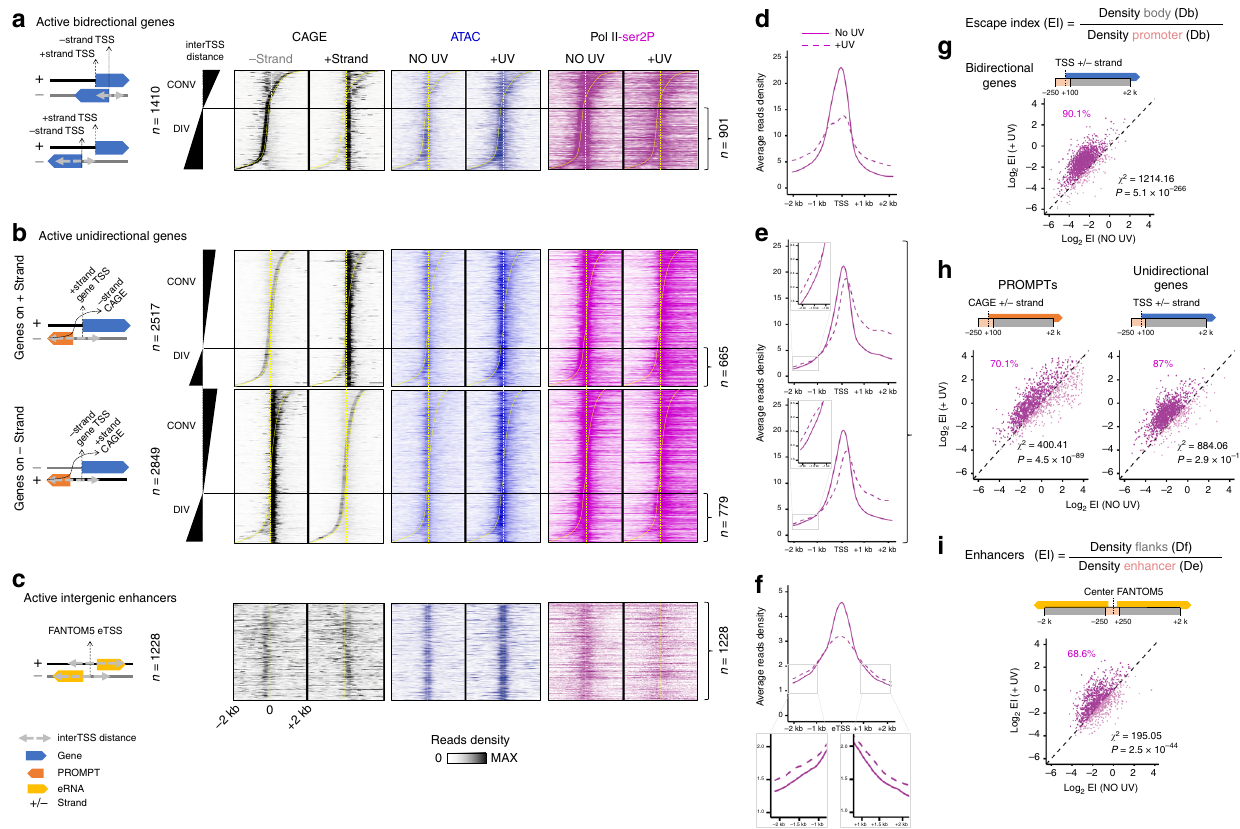
Fig. 3 Release of Pol II from pausing sites in coding and non-coding transcribed regions upon UV stress. a (Left) Scheme of convergent ( “ CONV ” , overlapping) and divergent ( “ DIV ” , non-overlapping) active bidirectional promoters expressing two mRNAs (blue arrows). (Right) Heatmap showing the distribution of CAGE (black; − and + strand separately) in the steady state, and ATAC-seq (blue) and Pol II-ser2P (purple) read densities, before (NO UV) and 2 h after UV ( + UV) around + strand TSS (±2 kb). Loci are sorted by inter-TSS distance (( + strand TSS)-(-strand TSS)). Data for Pol II-ser2P are obtained from ref. 25 and CAGE data from ref. 4 . Divergent loci correspond to inter-TSS >100 bp. b Same as in a but for active unidirectional genes TSSs, where PROMPTs (orange arrow) are transcribed in the opposite direction to the mRNA gene, from either the − strand (upper panel) or the + strand (bottom panel). Straight dashed lines indicate the position of mRNA TSS, and the sigmoidal dashed line indicates the variable relative position of CAGE PROMPT. Loci are sorted by inter-TSS distance (mRNA TSS - CAGE PROMPT) from the most convergent (mRNA and PROMPT overlapping, inter- TSS < 100 bp) to the most divergent (mRNA and PROMPT non-overlapping, inter-TSS > 100 bp) loci. c Same as in a , but for active intergenic enhancers expressing eRNAs (yellow arrow) in the opposite direction. d , e Average plots of Pol II-Ser2P before (solid line) and after UV (dashed line) on divergent categories de fi ned in a , b . Insets represent a zoomed view. f Same as in d , e , but for all active intergenic enhancers. g – i Comparison of escape index (EI), for indicated categories of d – f . Percentages of loci with increased EI after UV (dark purple) are shown. Chi-square test between active bidirectional and inactive unidirectional genes ( g ), active and inactive unidirectional genes, and active and inactive PROMPTs ( h ), and between active and inactive enhancers ( i ) was performed to determine whether the observed number of genes with Δ EI > 1 (number of genes with EI after irradiation greater than EI before irradiation) differs from the expected value purely by chance (see “ Methods ” for